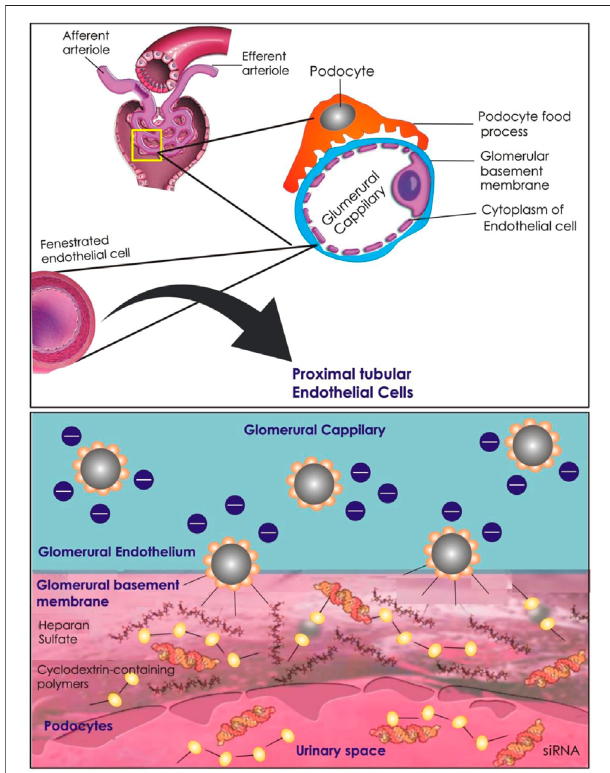
FIGURE 4 | Schematic illustration of siRNA-loaded NPs accumulation and dissociation in the GBM. NPs pass through the fenestrations in the glomerular endothelialcellliningand enter into theGBM. AttheGBM, theNPs are disassembled due to the high amounts of haparan sulfate. The NPs may then pass through the GMB, and after podocyte fi ltration, reach the Bowman ’ s capsule.